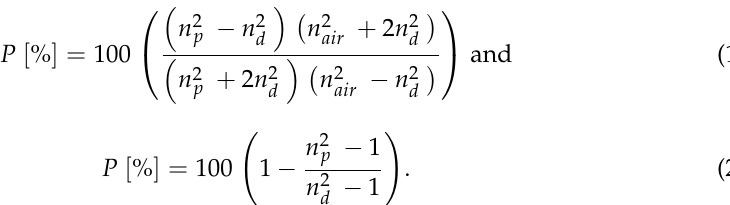
Si bulk substrate indicating the high reproducibility of the ZnO growth process with the porSiO 2 . ( b ) Currents up to the microampere range were emitted from the ZnO NWs on a membrane substrate. The corresponding current density is displayed on the right axis, which reveals the turn-on field of 3.0 V/ µ m for a current density of 0.1 µ A/cm 2 . Inset: The applied electric field of 3.4 V/ µ m was held constant two times for 94 min each, while the current was recorded to test the stability of the FE process. The emission current varied about 11% around a mean value of 2.8 µ A. The error bars display the standard deviations of the data points, and only every fifth error bar is shown for